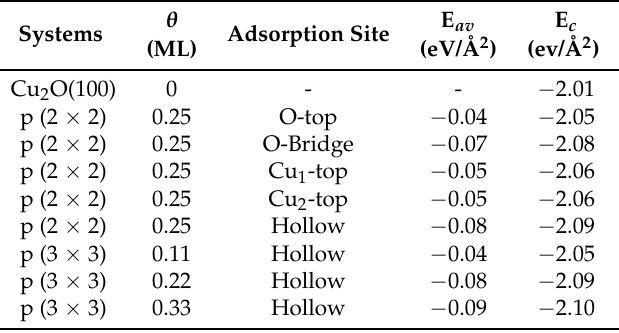
Table 1. Adsorption energy and surface cohesion energy for bismuth on the Cu 2 O(100)